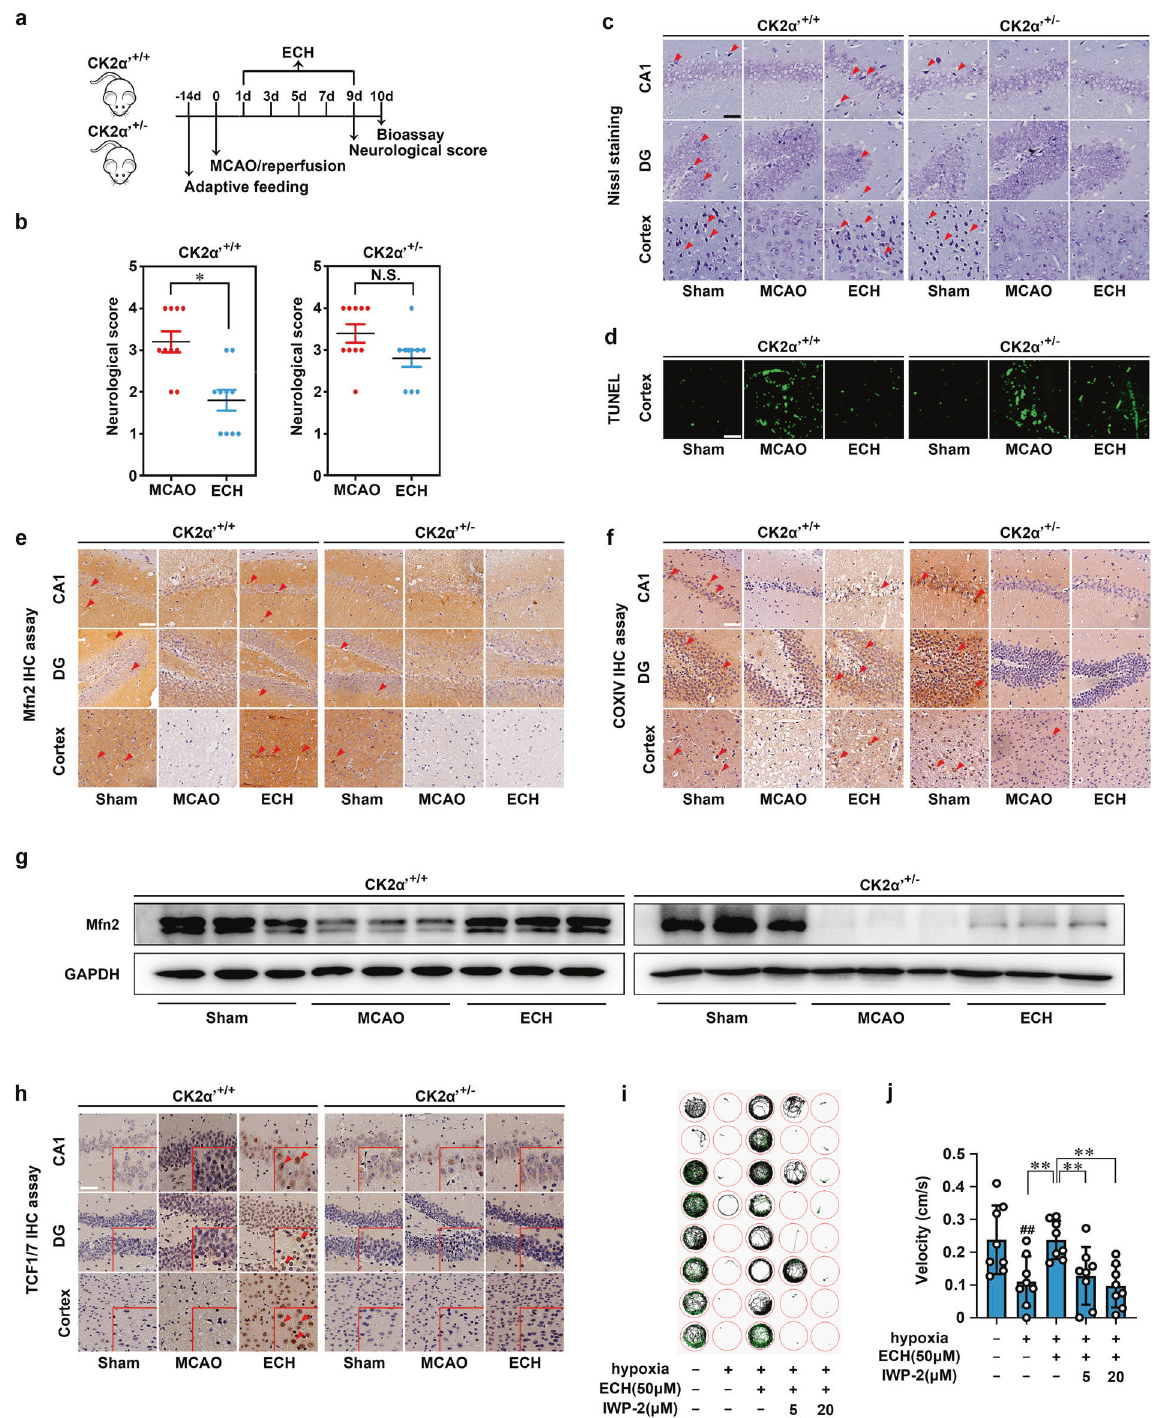
Fig. 6 CK2 exerts neuroprotection via promoting mitochondrial fusion in MCAO model. a Scheme of neuroprotection evaluation of ECH in MCAO model. MCAO were established on mice and ECH (50 mg/kg) was administrated for every 2 days, followed by neurological score test in day 9 and bioassay in day 10. b ECH improved neurological score against MCAO insult in CK2 α ′ + / + mice, but showed no effect in CK2 α ′ + / − mice. c ECH protected neurons against MCAO insult in CK2 α ′ + / + mice, but showed no effect in CK2 α ′ + / − mice. Neuroprotection in hippocampal and cortical areas were detected by Nissl staining assay. Arrows indicate Nissl bodies (scale bar: 50 μ m). d ECH inhibited cell apoptosis against MCAO insult in CK2 α ′ + / + mice, but showed no effect in CK2 α ′ + / − mice. Cell apoptosis was detected by TUNEL assay (scale bar: 50 µm). e Mfn2 expression was increased by ECH in CK2 α ′ + / + mice, but not in CK2 α ′ + / − mice (scale bar: 50 μ m). f ECH-induced mitochondrial fusion was suppressed in CK2 α ′ + / − mice, which was stained with the speci fi c mitochondrial marker COXIV (scale bar: 50 μ m). g CK2 α ′ + / − blocked ECH-induced Mfn2 expression increase, which was detected by western blot assay. h TCF1/7 signi fi cantly translocated into nucleus upon ECH treatment (scale bar: 50 μ m). i , j Swimming performance analysis for ECH and IWP-2 neuroprotection in ischemia/ reperfusion-induced zebra fi shes. Data are expressed as the mean ± SD. ## P < 0.01 vs. control group. * P < 0.05, ** P < 0.01 vs. MCAO group. NS not signi fi